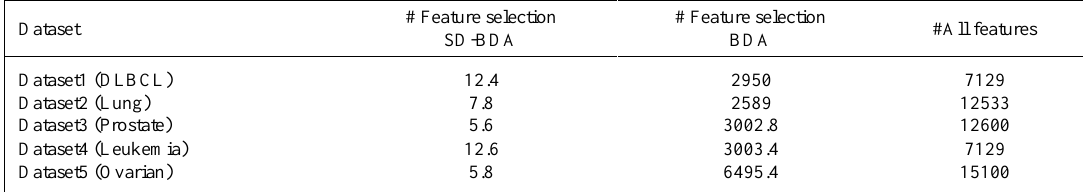
Table 2. A comparison between the SD-BDA and BDA in the average of feature selection